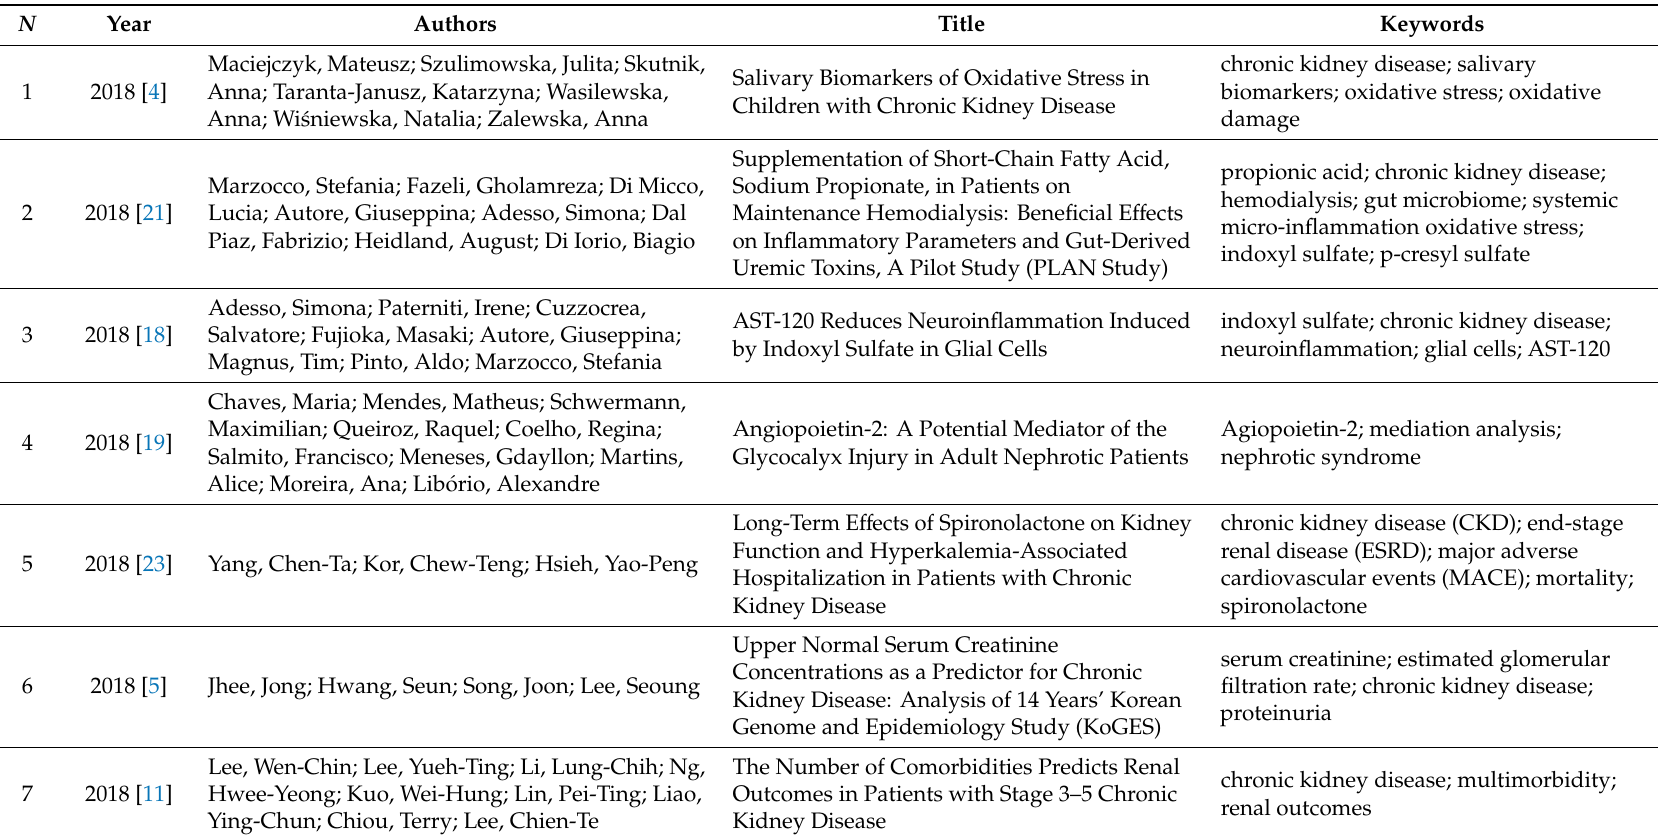
Table 1. List of all published articles with the special issue “Clinical Symptoms, Diagnostics and Treatments of Chronic Kidney Diseases (CKD)” between June 2018 and June